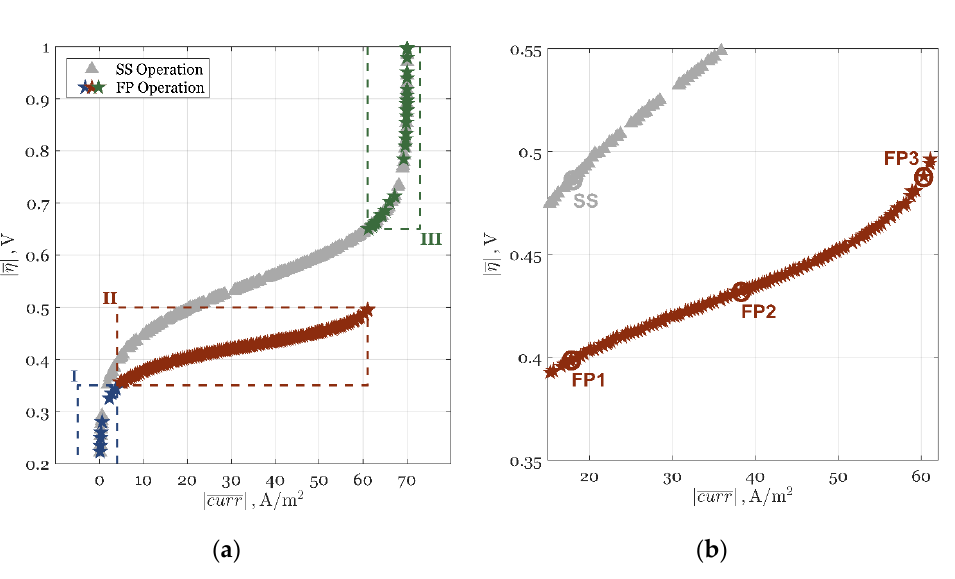
Table 5. Pareto optimization criteria for Example 2: ECR.